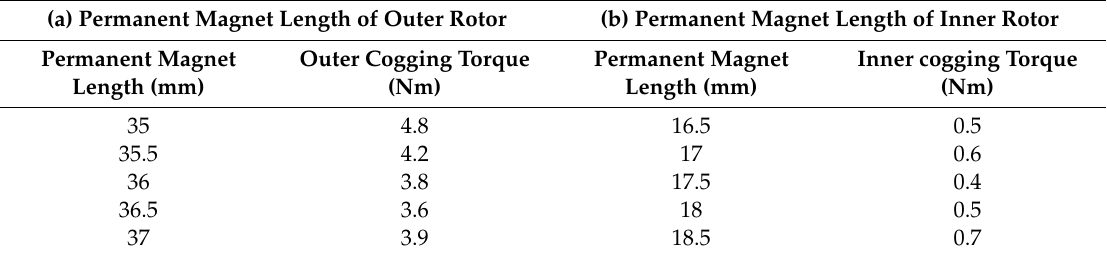
Table 3. Detailed analysis of the magnet length and inner cogging torque of dual rotor.